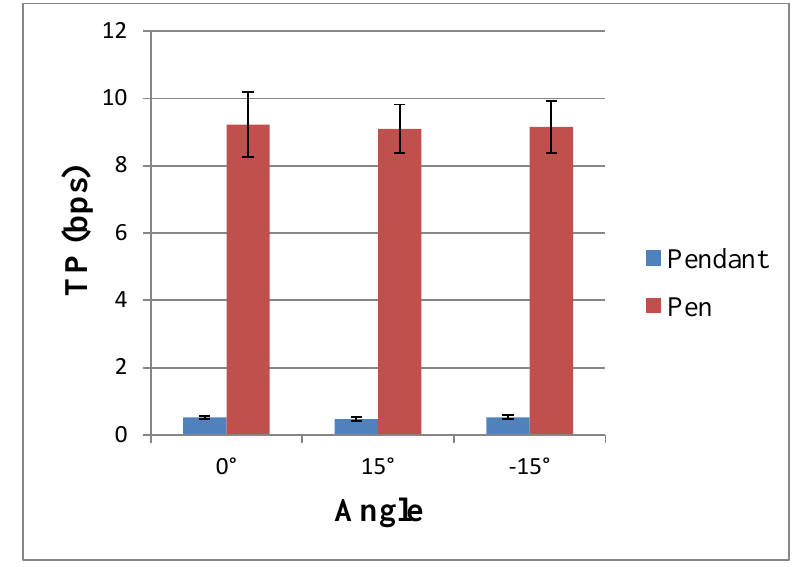
Figure 10. Bar chart of the TP for operating the two tools at three inclination angles.